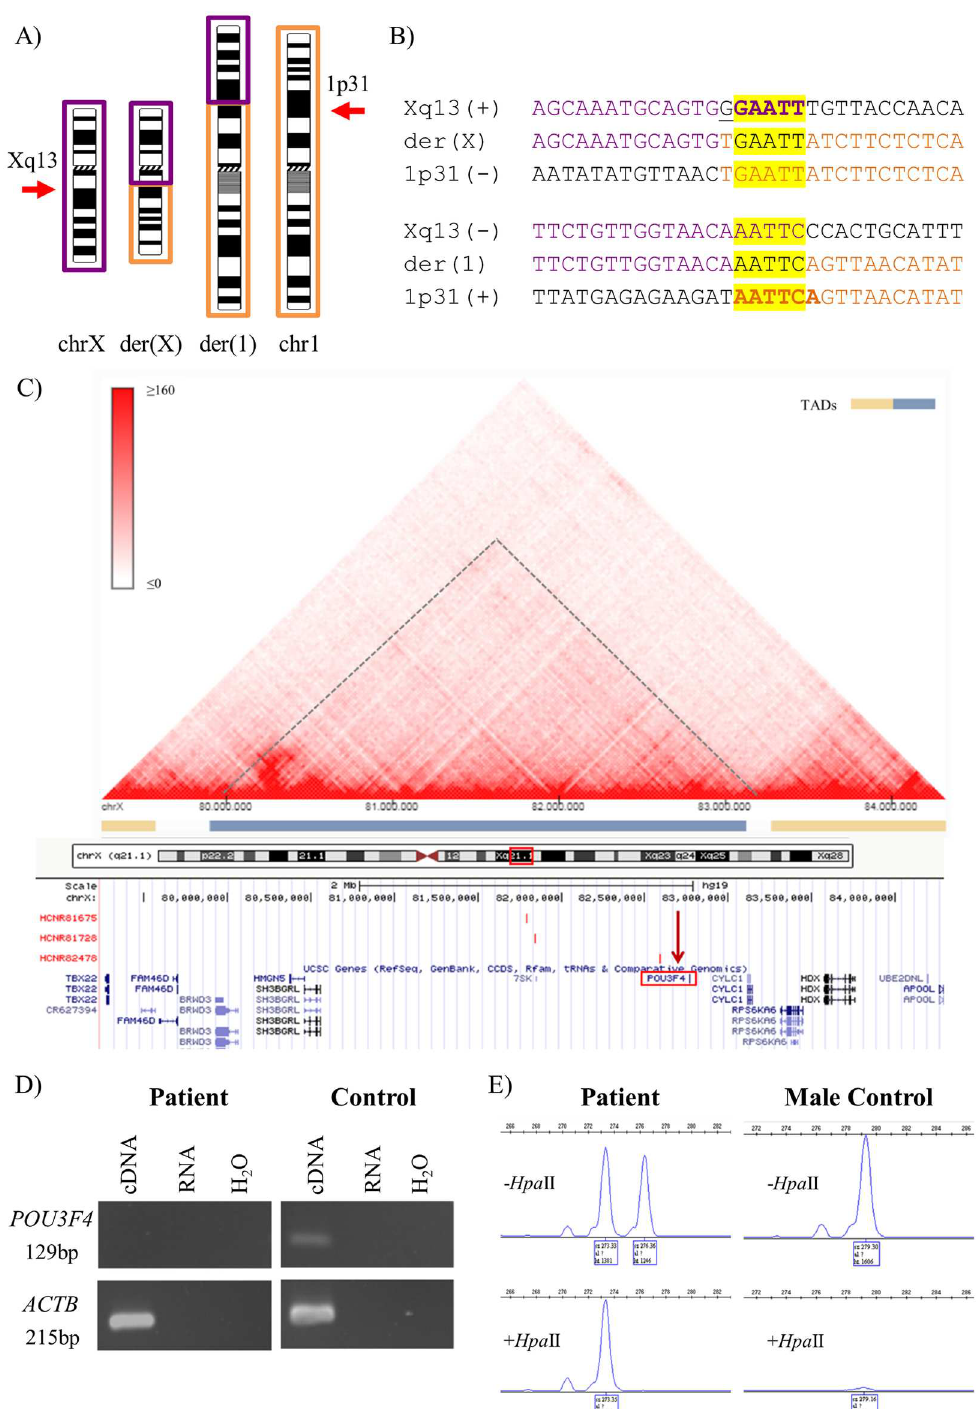
Fig 1. Summarized karyotype, WG-MPS, Sanger sequencing, RT-PCR and X-inactivation results from Case 1. A) Partial ideograms showing the normal and derivative (der) chromosomes (chr) X (purple) and 1 (orange) (not to scale) in Case 1. Xq13 and 1p31 breakpoints are indicated by arrows. B) Derivative translocation junction sequences (middle line) and matching reference sequences (top and bottom lines) as identified by Sanger sequencing. Microhomology is highlighted in yellow, deleted sequences are underlined, and duplicated sequences are in bold letters. C) Schematic illustration of the Topologically Associated Domain (TAD) structure at the POU3F4 locus (indicated with a dashed line